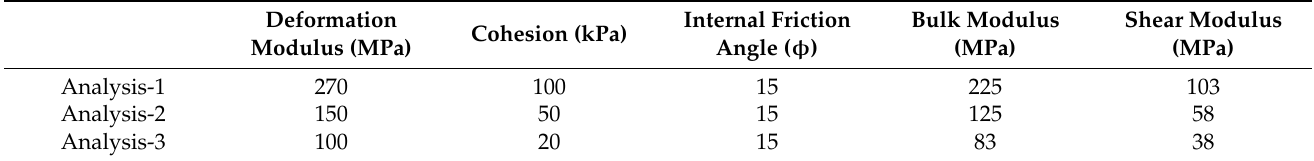
Figure 9. Deformations in Z-direction ( a ) and Y-direction ( b ). (units in m). Table 2. Rock mass parameters employed during the back analyses.